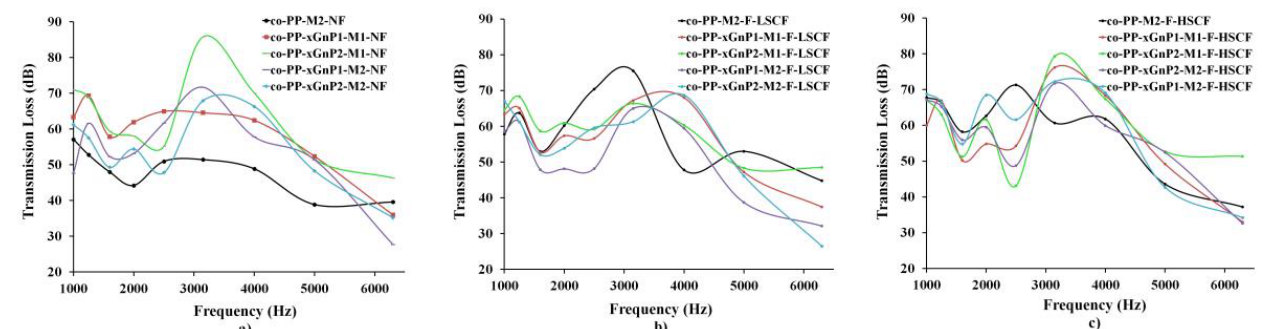
Figure 12. Sound transmission loss results of ( a ) nonfoam (solid), ( b ) foam with a low SCF amount and ( c ) foam with a high SCF amount. SCF: supercritical